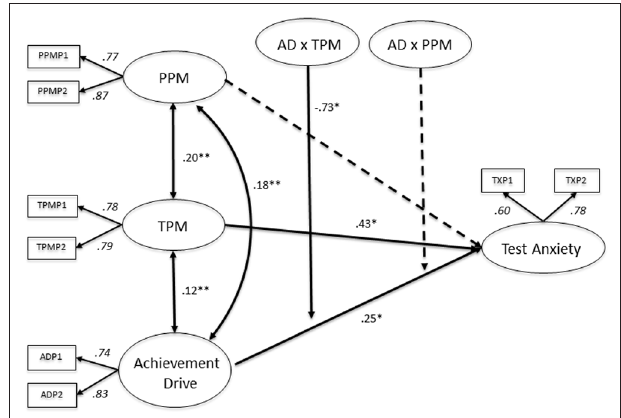
FIGURE 7 | Multigroup latent moderated structural equations (MGLMS) for the German sample. Significant effects shown as unstandardized coefficients (B), bold pathways are significant at * p < 0.05, ** p < 0.001; dotted pathways are not significant. Factor loadings are standardized (based on the standardized results of the weak measurement model seen as the final model only reports unstandardized results). PPM, peers as